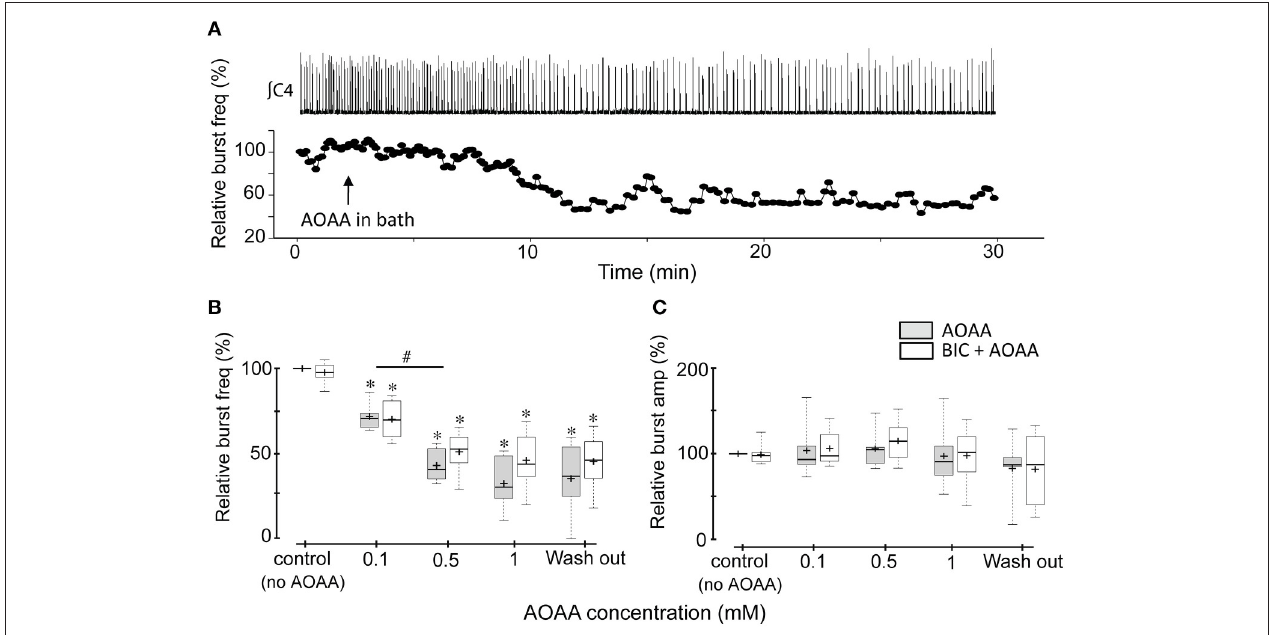
FIGURE 1 | Effects of AOAA on rhythmic inspiratory-related activity recorded from the C4 ventral root of BSSC preparations. (A) Representative BSSC preparation showing the time course of how instantaneous frequency, calculated from the recording shown ( R C4, top trace), changes following bath application of 1mM AOAA (indicated by the black arrow). The time scale of the nerve recordings and instantaneous frequency plots are matched. (B,C) Box plots of group data showing the dose-dependent effects on C4 inspiratory burst frequency (B) and amplitude (C) of AOAA bath-applied alone ( n = 7), and, in a different group of BSSC preparations, in combination with bicuculline (3 µ M, n = 8). The effect of bicuculline alone is presented in the control group data set. *Indicates significant difference ( p < 0.05) compared to control (baseline), # Indicates significant difference ( p < 0.05) between the indicated